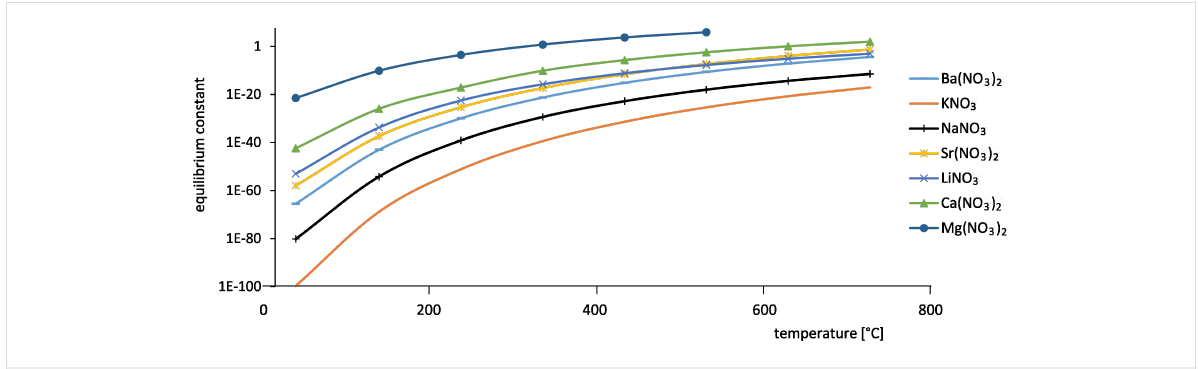
Figure 6: Temperature dependent equilibrium constant for alkali metal nitrates and alkaline metal nitrates.